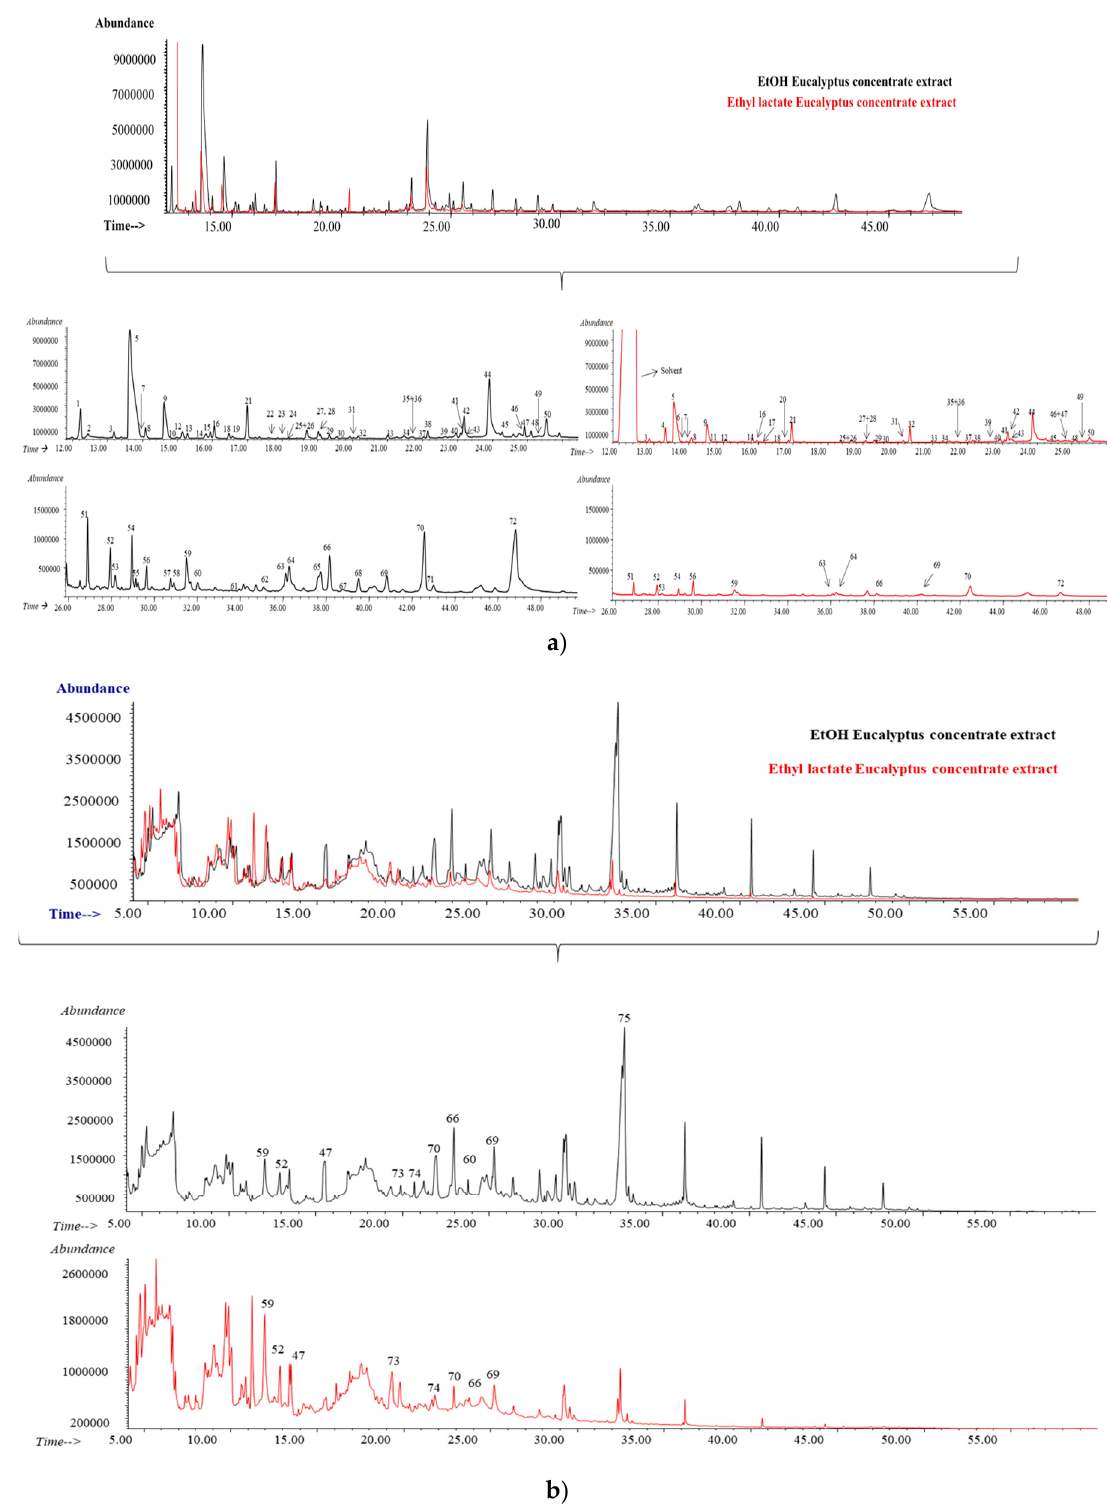
Figure 5. Chromatographic profile obtained for the ethanolic (black) and ethyl lactate (red) extracts derived from the concentrate of Eucalyptus in the ( a ) polar column and ( b ) non-polar column.